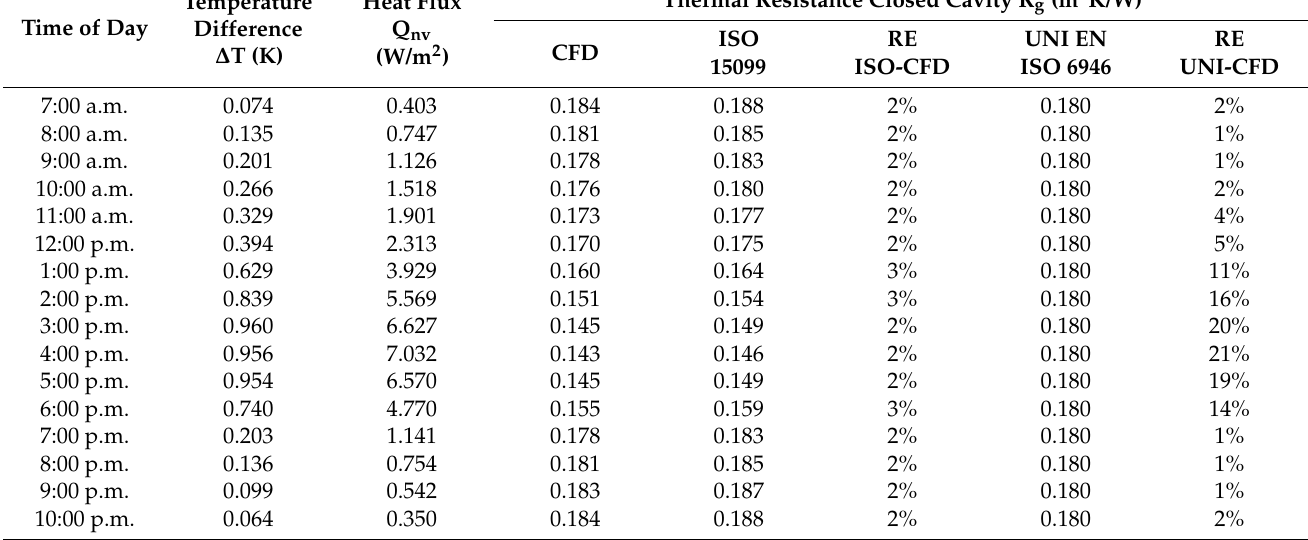
Table 4. Values of the delta temperature between the cavity faces, heat flux through the cavity and thermal resistance of the cavity obtained from the CFD simulations for the closed cavity; comparison with the thermal resistance values calculated according to ISO 15099 and UNI EN ISO 6946. The relative error (RE) indicates the difference of the CFD results from the standards.